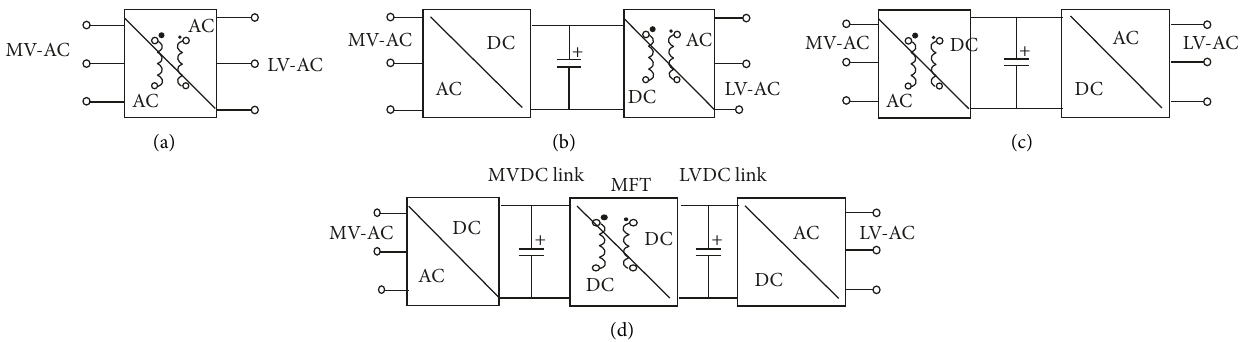
Figure 1: Basic ST topologies. (a) Single stage AC-AC, (b) two stage with MV DC link, (c) two stage with LV DC link, and (d) three stage with dual DC link.